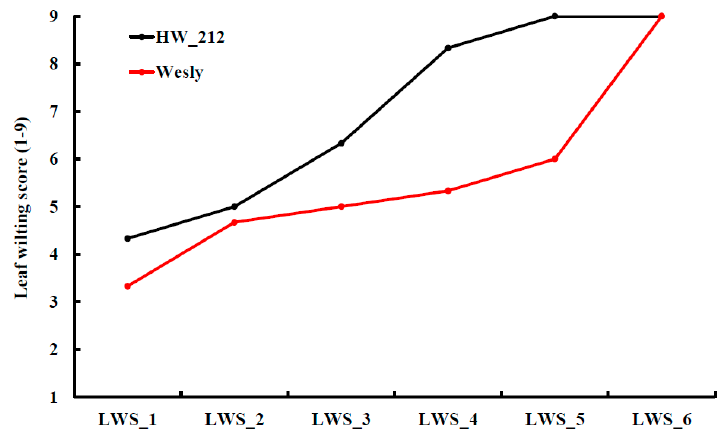
Figure 2. Phenotypic variation between HW — 212 and Wesley in leaf wilting symptoms during drought treatment. Anoton is the tolerant check (American cultivar) [8].